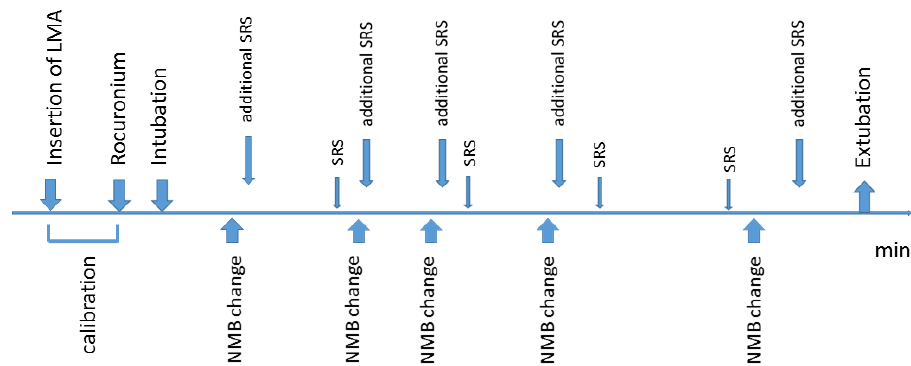
Figure 1. Timeline of the observations. Acceleromyography was performed every 15 s. Surgical rating score (SRS) was assessed (i) every 15 min, (ii) when the degree of the neuromuscular block (NMB) changed, and (iii) in case of deterioration of the surgical conditions, requiring injection of rocuronium. LMA: laryngeal mask airway; SRS: regular assessment of SRS every 15 min; NMB change: change of the degree of the NMB; additional SRS: assessment of SRS in case of change of the degree of the NMB.